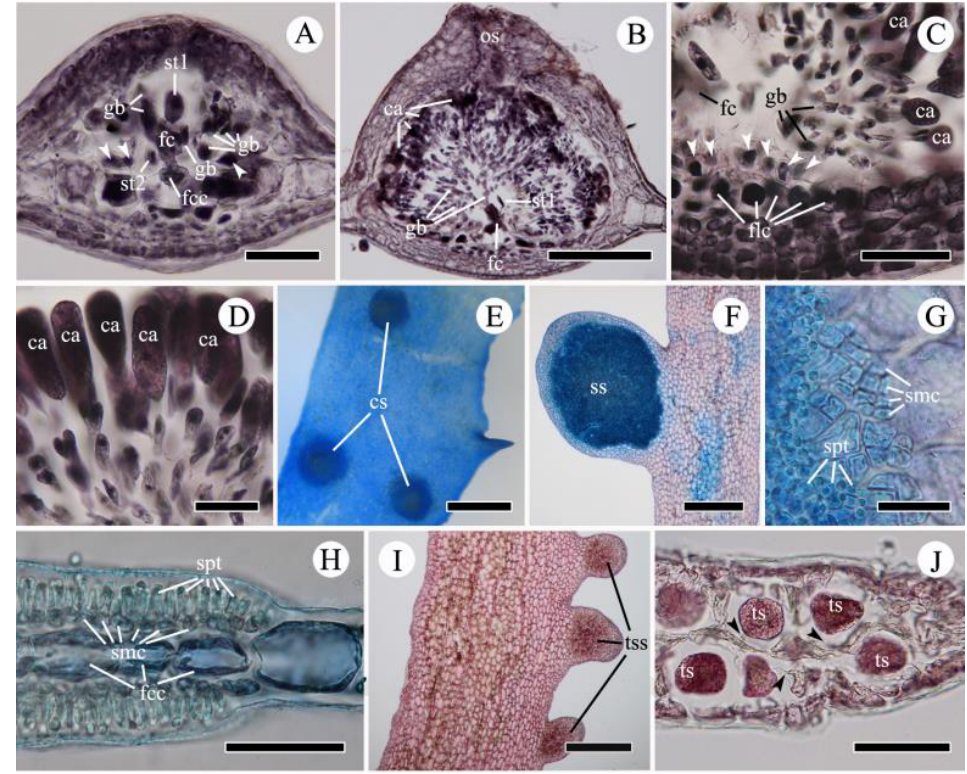
Figure 6. Reproductive structures of Acrosorium flabellatum Yamada. ( A , B ) Cross-sectioned young ( A ) and mature ( B ) cystocarp. ( C ) Base of cystocarp (arrow heads: small cells from floor cells). ( D ) Carposporangia. ( E ) Surface view of mature cystocarp. ( F ) Spermatangial sorus. ( G , H ) Surface ( G ) and cross-sectional views ( H ) of spermatangial sorus. ( I ) Tetrasporangial sori. ( J ) Cross-sectioned tetrasporangial sorus (arrowheads: pit-connection). ca, carposporangium; cs, cystocarp; fc, fusion cell; fcc, fertile central cell; flc, floor cell; gb, gonimoblast cell; smc, spermatangial mother cell; spt, spermatangium; ss, spermatangial sorus; st1, first sterile cell group; st2, second sterile cell group; tss, tetrasporangial sorus; ts, tetrasporangium. Scale bars: ( E ), 1 mm; ( F , I ), 500 µm; ( B , J ), 300 µm; ( A , C ), 100 µm; ( D , H ), 50 µm; ( G ), 30 µm. Spermatangial sori are produced on both surfaces of small marginal proliferations (Figure 6F). Spermatangial mother cell initials are cut off fertile central cells by periclinal divisions on both blade surfaces. The initial cells divide anticlinally several times to form spermatangial mother cells, all of which cut off one to two clavate spermatangia (Figure 6G,H). Tetrasporangial sori are formed on small marginal proliferations (Figure 6I). The tet- rasporangia are globose, 70‒100 µm in diameter, and tetrahedrally divided. They are usually cut off from central cells, or, rarely, from inner cortical cells, and arranged in two layers on opposite sides of the central cells (Figure 6J).